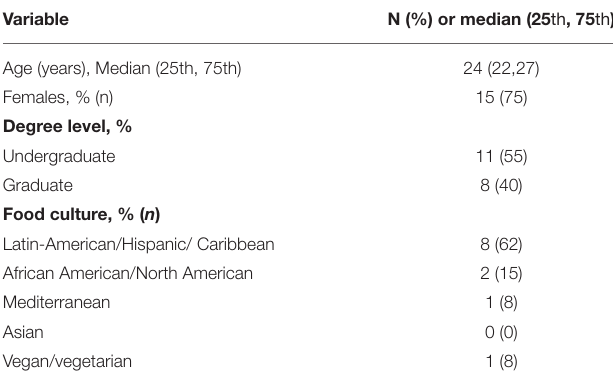
TABLE 1 | Demographic characteristics of study participants ( n = 20).